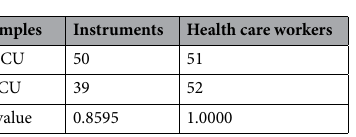
Table 7. Growth isolated from NICU and PICU. P value > 0.05, hence the values are non-significant.